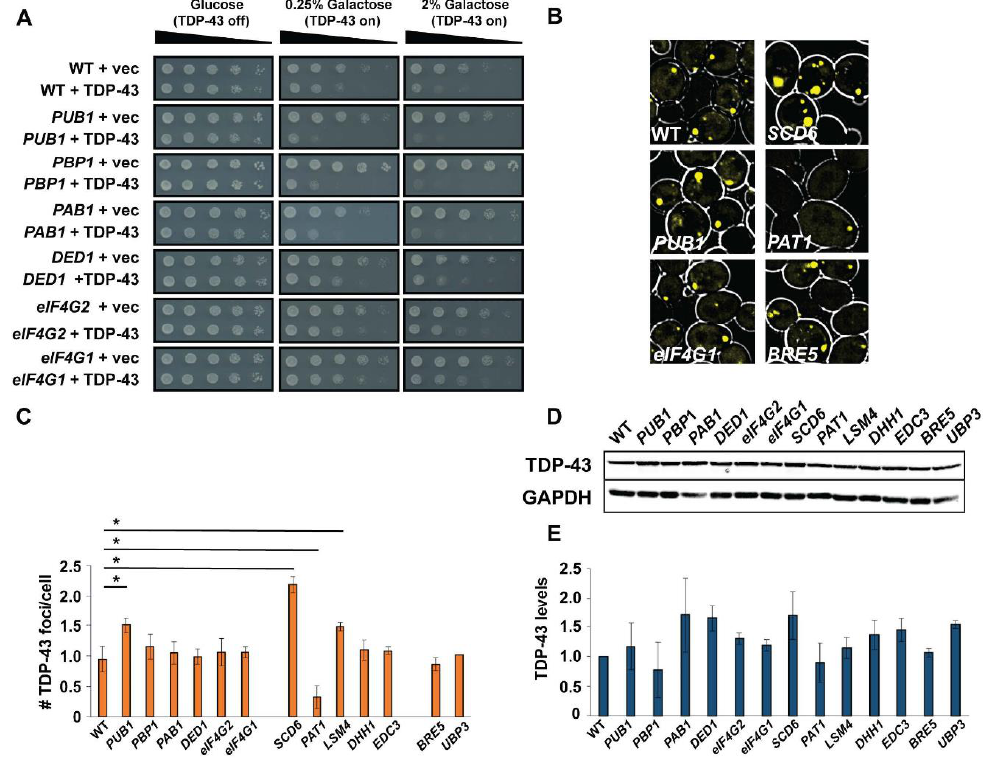
Figure 3. Over-expression of SG proteins has variable e ff ects of TDP-43 toxicity, foci formation and abundance. ( A ) BY4741 (WT) and indicated SG assembly protein over-expression strains were transformed with pRB109 expressing TDP-43-YFP and multi-copy plasmids containing indicated genes of interest under native promoter control. TDP-43 toxicity was examined by serial dilution spotting assay. ( B ) Select microscopy images of TPD-43-YFP foci in cells over-expressing indicated SG / PB assembly proteins. ( C ) Quantification of average TDP-43 foci / cell for the complete SG / PB protein over-expression dataset. Data generated from 3 biological replicates with mean ± s.d shown. An ANOVA with Dunnet’s post-hoc test was used to assess significance. ( D ) Western blot of TDP-43-YFP protein levels in indicated over-expression strains. ( E ) Quantitation of data in ( D ), based on 2 test was used to assess significance (* indicates significance).